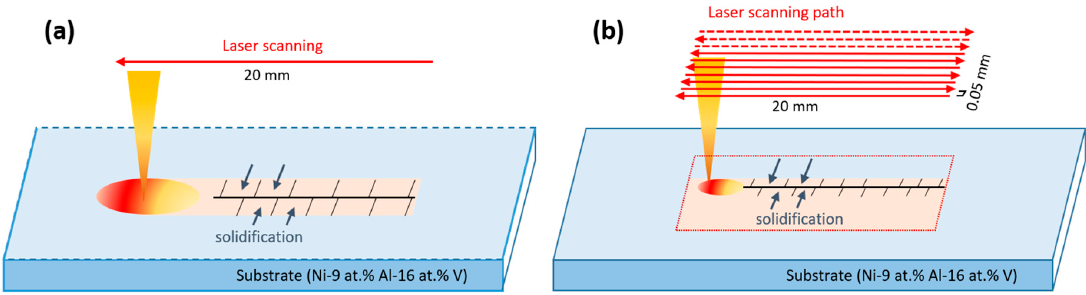
Figure 2. Illustration of the laser scanning path used for the Ni-9 at.% Al-16 at.% V alloy substrate: ( a ) line scan and ( b ) wide-range scan.